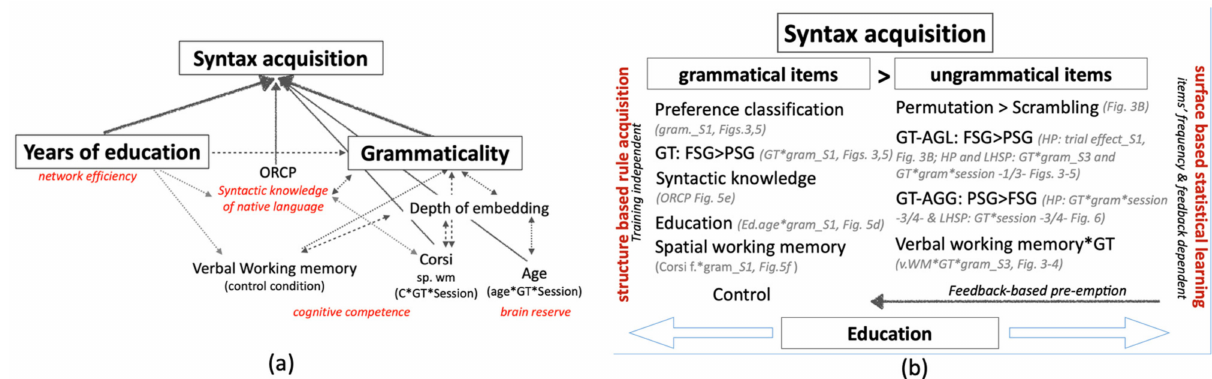
Figure 7. Summary of results. ( a ) List of syntax-internal and syntax-external factors that signif- icantly predicted AGG and AGL. Black arrows display variables that were significant as a fixed effect in AGL and AGG, whereas dotted black arrows indicate interactions between variables, and gray arrows correlations between them (see Supplementary data analysis). Grammaticality and education were the most relevant predictors for syntax acquisition (see Figures 3–6). ORCP, age and Corsi showed significant interactions with session and syntax-internal variables in the model including Sessions (Figure 5). The depth of embedding was not a predictor itself, but it interacted with Grammaticality and verbal WM (Figure 4), as well as with sessions and Corsi (PSG) or Age (FSG). Notably, some variables, such as age and education, significantly correlated, but showed different interactions. ( b ) Summary of all the significant predictors of accuracy on grammatical and ungrammatical items. The interaction with the other variables supports the dual-process account of artificial grammar